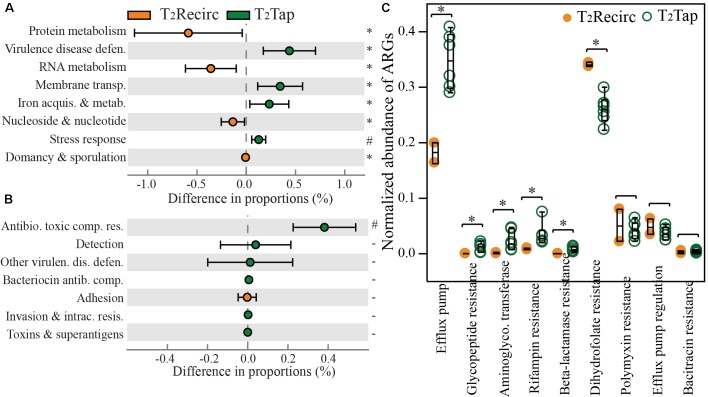
Functional gene shifts following stagnation of hot water in distal taps sampled at T2. Comparing recirculating hot waters with tap waters in the proportions of (A) level-1 course categories; (B) level-2 finer classifications of the virulence disease defense function in panel A; and normalized abundance of (C) ARGs. T2Recirc includes two recirculating waters and T2Tap has six distal tap samples, from both rigs at T2. Orange and green circles in panel A represent functions with a higher proportion in T2Recirc and T2Tap, respectively. Error bars in panel A represent standard deviations. The symbol ‘∗’ indicates p-value < 0.05 (0.011 to 0.044), ‘#’ indicates p-value < 0.001, and – indicates p-values >0.05 (0.241–0.977) from STAMP analysis. Normalized abundance of ARGs was dividing the count of reads annotated as an ARG by the count of 16S rRNA genes.